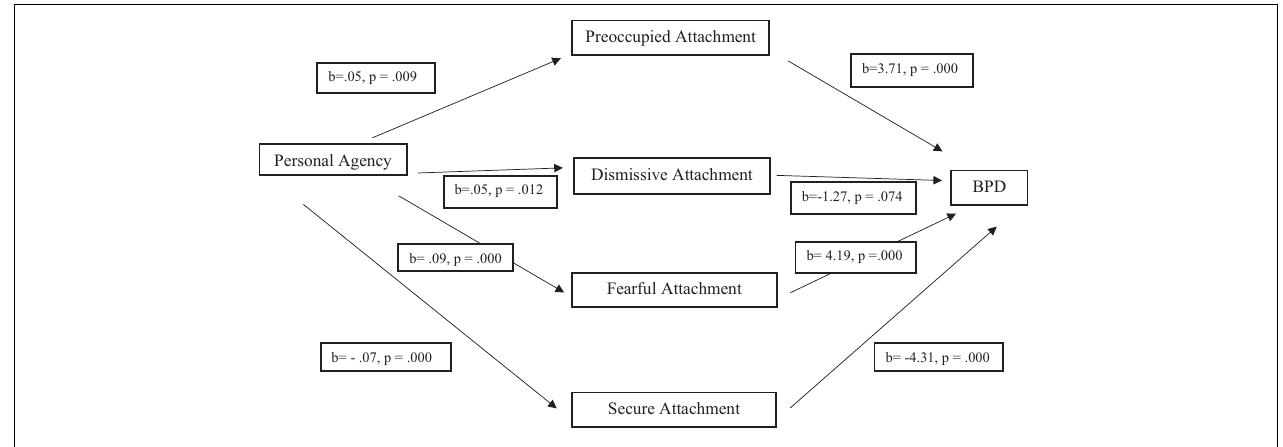
FIGURE 1 | Multiple mediation analysis of personal agency to BPD through four attachment